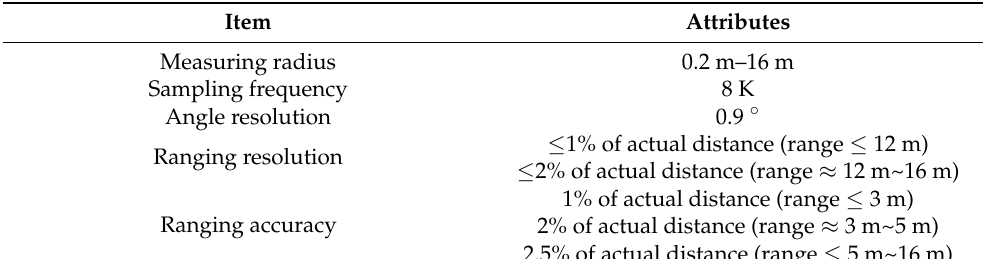
Table 2. Device parameters of AH-100B inertial measurement unit.